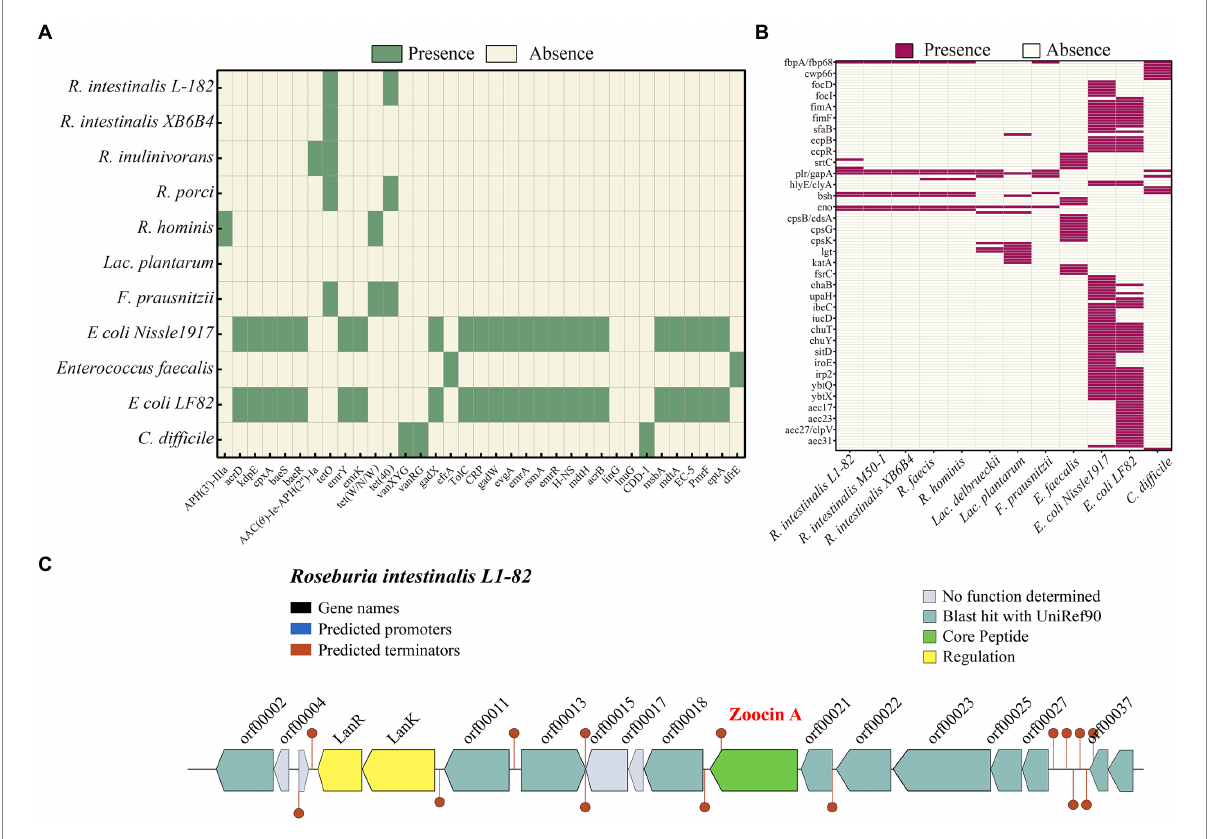
FIGURE 3 Heatmap showing the clustering of the compared R. intestinalis genomes based on the presence of antibiotic resistance genes (A) and virulence genes (B) . (C) Organization of bacteriocin cluster genes. orf00002, RNA pseudouridine synthase; orf00011, S-adenosylmethionine synthase; orf00013, Cyclic di-GMP phosphodiesterase; orf00018, UDP-N-acetylglucosamine 1-carboxyvinyltransferase; orf00021, Shikimate kinase; orf00022, Foldase protein PrsA; orf00023, Transcription-repair-coupling factor; orf00025, Peptidyl-tRNA hydrolase; orf00027, Bifunctional protein GlmU; orf00037, Putative septation protein SpoVG; orf00039, Glucose-1-phosphate adenylyltransferase.